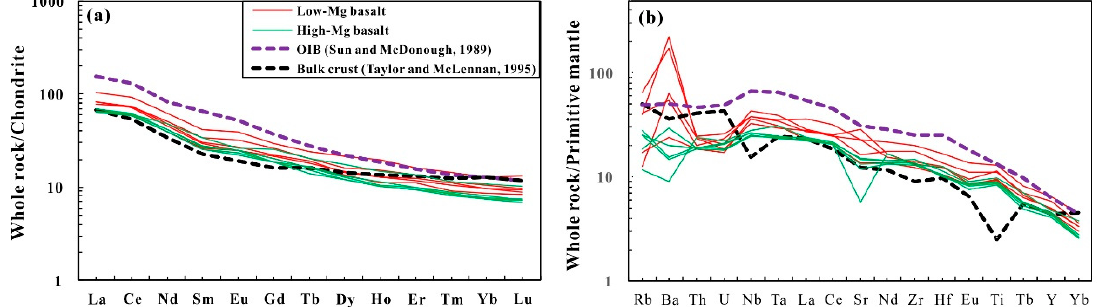
Figure 4. ( a ) Chondrite-normalized REE patterns of the low-Mg and high-Mg basalt. ( b ) Primitive mantle-normalized diagrams of incompatible elements for the low-Mg and high-Mg basalt. (The Chondrite and Primitive mantle values from Sun and McDonough (1989) [68]).